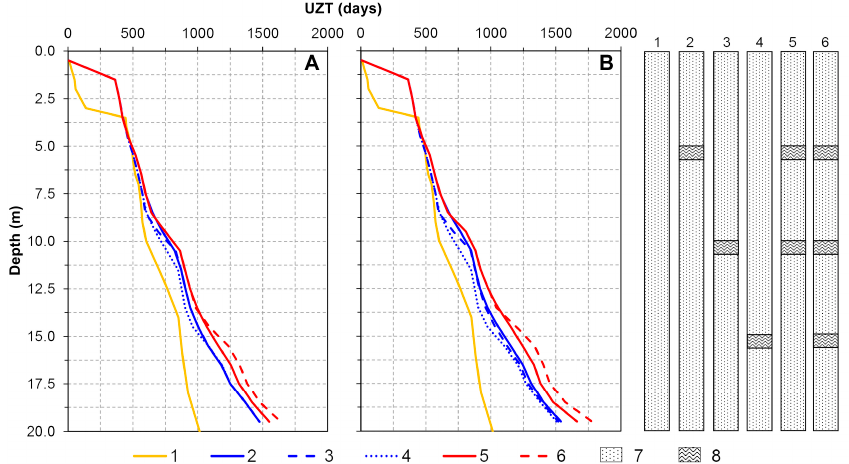
Figure 7. Variation of UZT and depth obtained for heterogeneous hydro-stratigraphic models characterized by a homogeneous (1) soil column of loamy sand, with a single (2, 3, 4) double (5) or triple (6) 1-m thick intercalation of silt ( A ) or clay ( B ) located at different depths. Other keys to symbols: (7) loamy sand; (8) silt or clay.